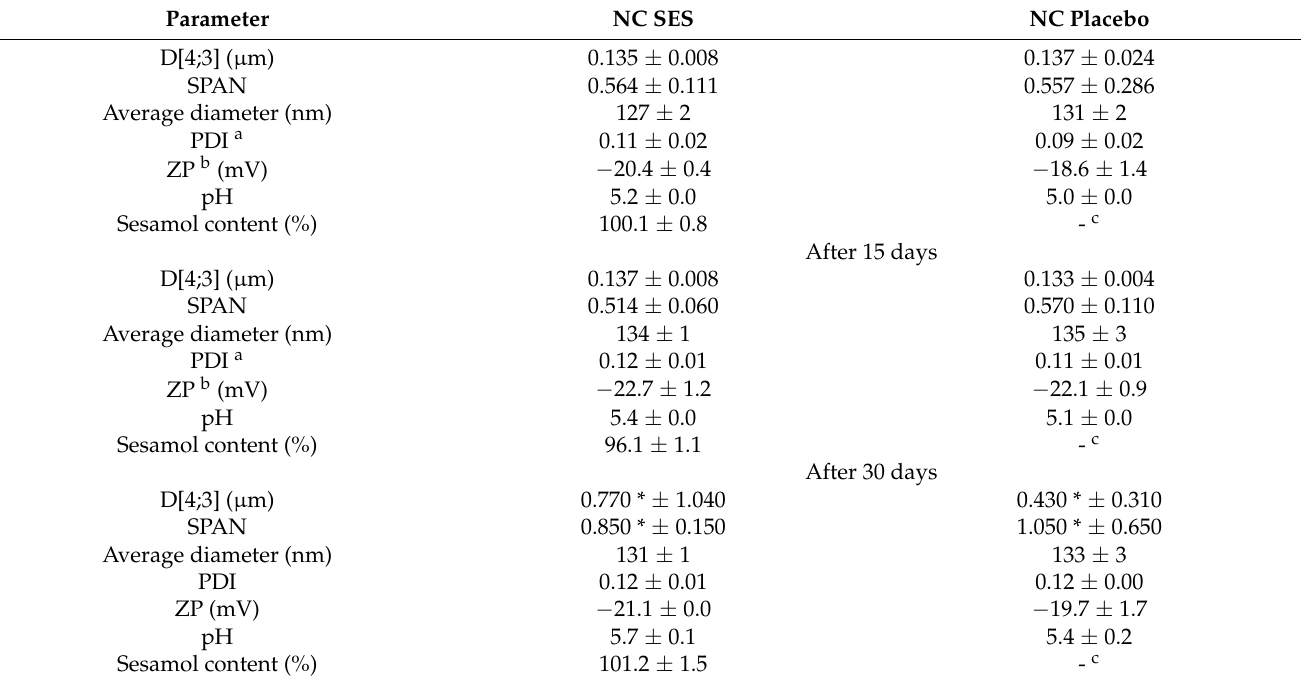
Table 1. Characterization parameters of the sesamol-loaded nanocapsule suspension (NC SES) and its respective unloaded (NC placebo)